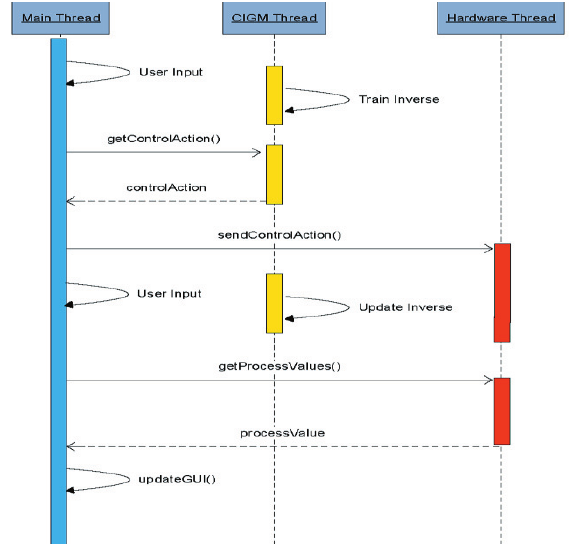
Fig.2: Threads execution and